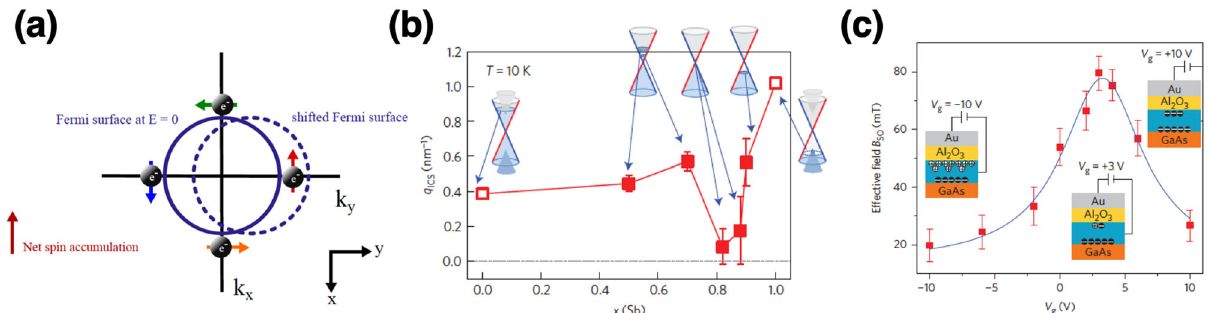
Fig. 5 Topological spin – orbit torque (SOT). a Schematic of the physics behind the SOT, namely, when an electric fi eld is applied to a topological insulator, the shift of the Fermi surface causes an imbalance in spins allowing a spin Hall current to develop perpendicular to the charge current fl ow on the surface 71 . Reprinted by permission from ref. 71 , copyright 2014. b Experimentally obtained value of the spin Hall angle, or q ics here, as a function of the position of the Fermi level demonstrating the importance of tuning the Fermi level in a topological SOT device 72 . Reprinted by permission from ref. 72 , copyright 2016. c Plot of the value of the spin Hall angle as modulated by an applied electric fi eld in a magnetic topological insulator 73 . Reprinted by permission from ref. 73